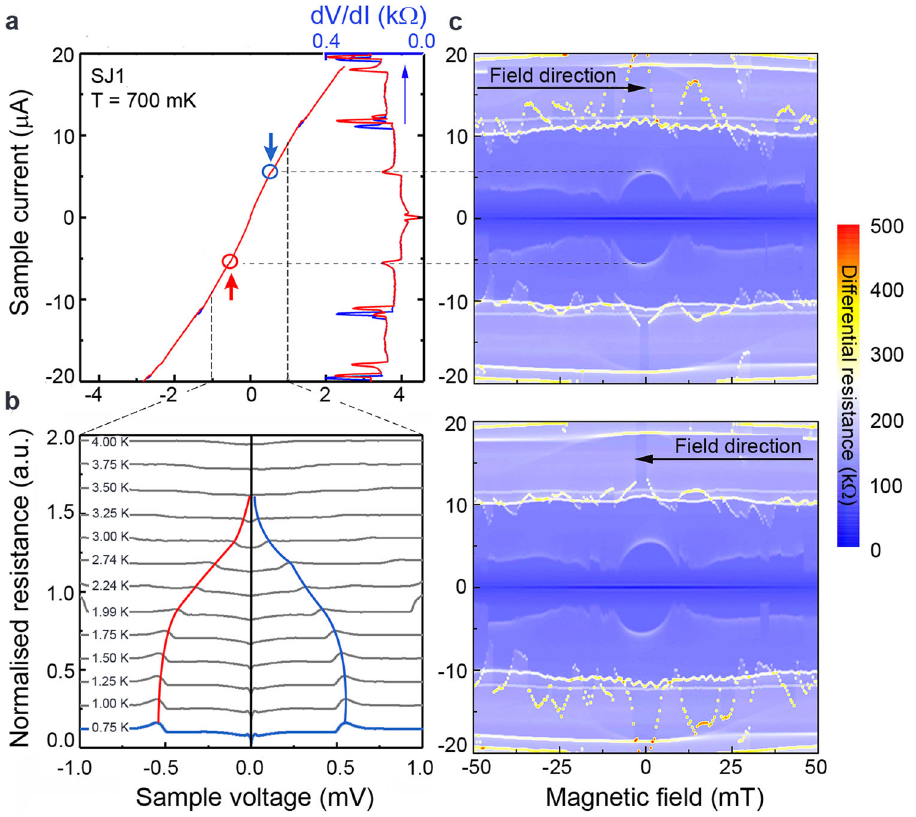
Fig. 5 Behavior of the device SJ1 at high currents and bias. a I ( V ) curves (blue and red lines) acquired at 700 mK for the two opposite directions of the current sweep. The corresponding differential resistance d V /d I ( V ) curves (at the right) shows step-like jumps separated by sharp peaks. Unlike other peaks, the one at ~±6 μ A shows no hysteresis (the event is also marked by red and blue circles and arrows on I ( V )). b Temperature evolution of the differential resistance d V /d I ( V ) spectra. Red and blue lines follow the temperature evolution of the peaks. c Evolution of the differential resistance in the magnetic fi eld (for the two opposite directions of the fi eld sweep). Hysteretic peaks evolve “ chaotically ” yet deterministically; the nonhysteretic peak shows a completely different dome-like smooth